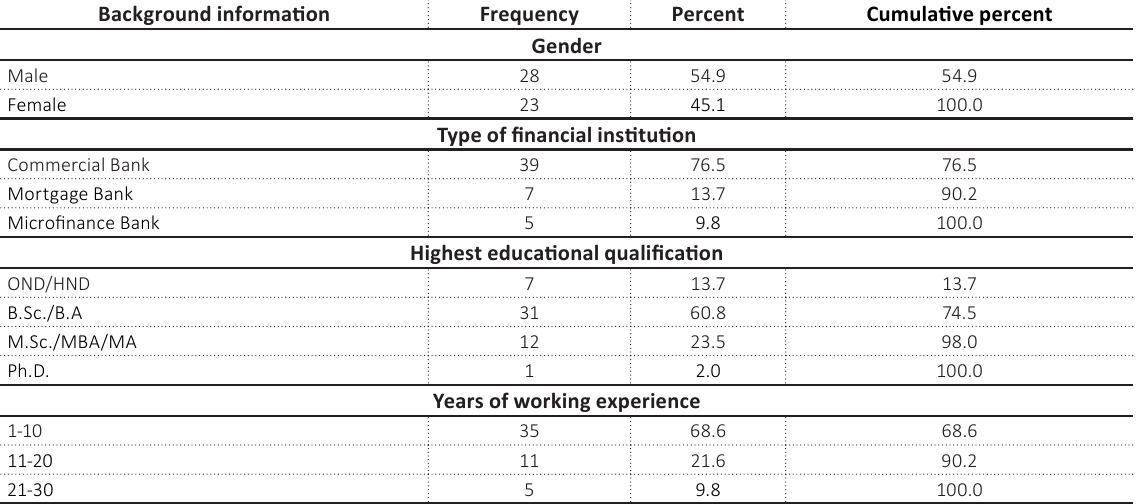
Table 1. Summary of background